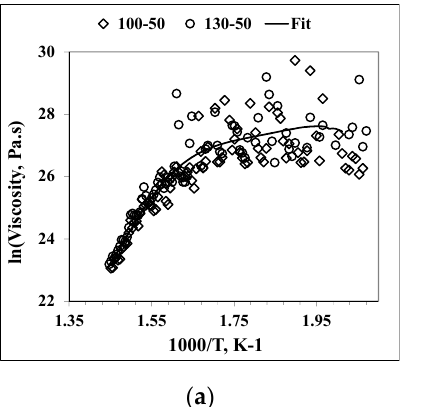
Figure 3. Viscosity temperature dependence of the Pd 40 Ni 40 Si 20 glassy alloy at a heating rate of 20 K/min, calculated from load differences ( a ) and the viscosity temperature dependence of the Pd 40 Ni 40 Si 20 glass: points — experimental values; broken line — best fit values, according to FVM; and the steep solid line — quasi-equilibrium viscosity ( b ). The cross point of the non-equilibrium and quasi- equilibrium viscosity determines the glass transition temperature T g .